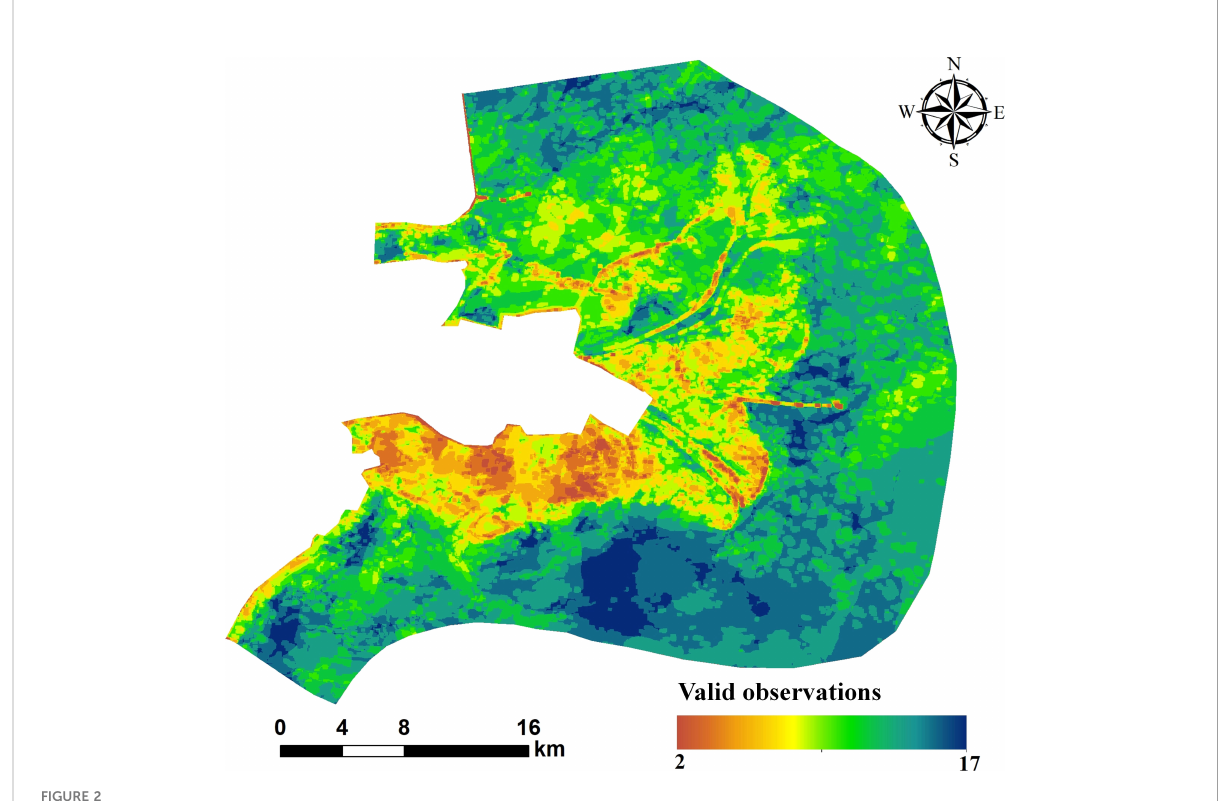
FIGURE 2 Landsat 8 OLI good observations in the Yellow River Delta in